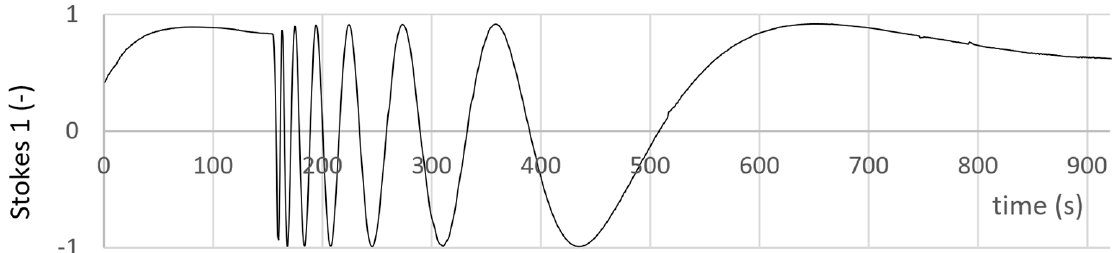
Figure 9. Changes in the Stokes parameter S 1 : changes in the polarization state occurred when connecting a single-fiber polarization sensor [6], FBGs, and DWDM technology (a measurement of 364 s).